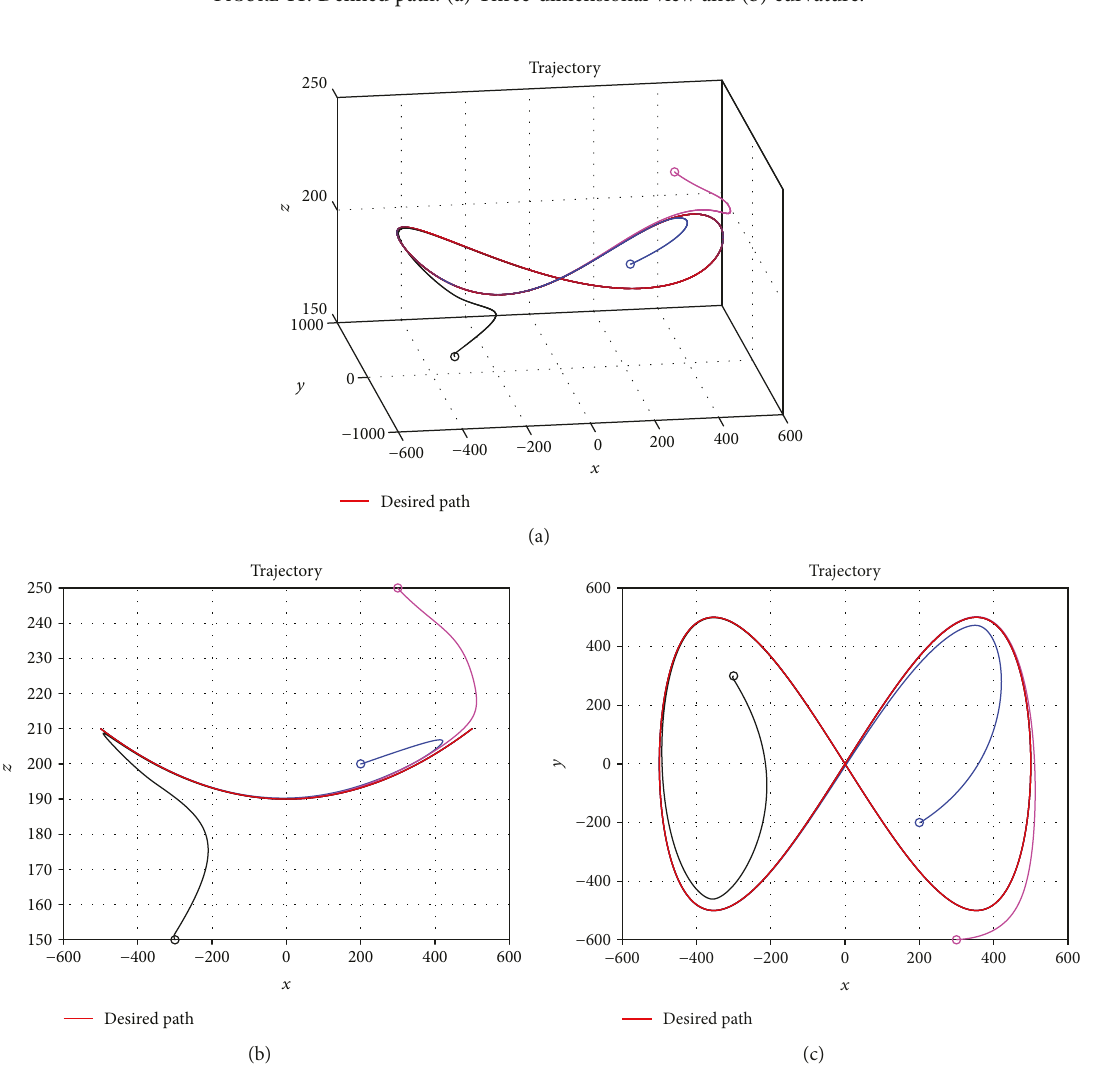
Figure 12: General path following. (a) Three-dimensional view, (b) side view, and (c) planar